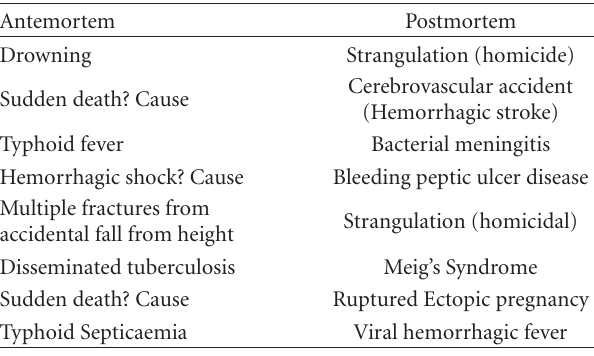
Table 3: Medicolegal and hospital autopsies with their correspond- ing antemortem diagnosis found helpful to law enforcement agents and